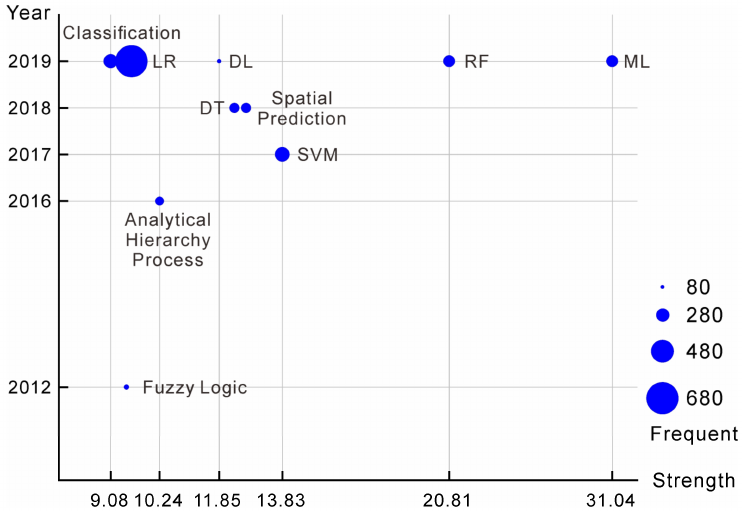
Figure 5. Citation burst of AI in geohazard research during 1990–2022 (logarithmic